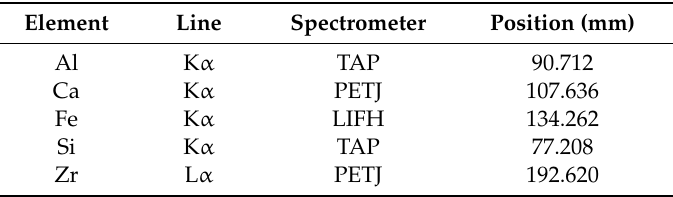
Table A1. Spectrometer setup for the EPMA high-resolution mappings.